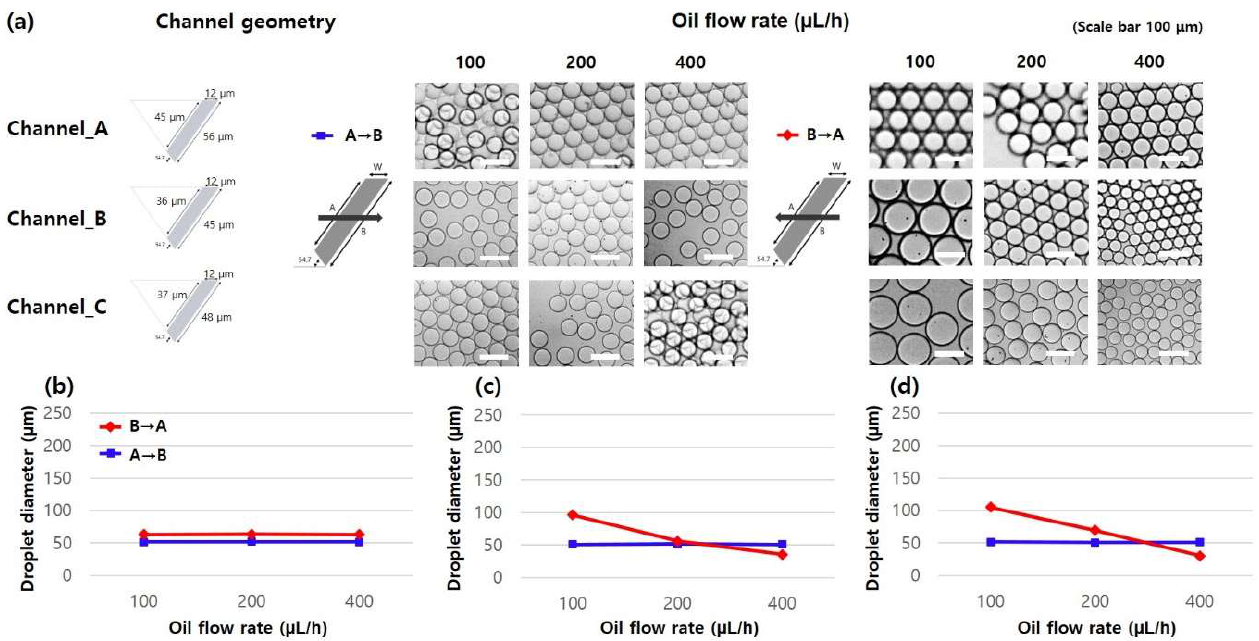
Figure 6. ( a ) Microscopic images of micro-droplets generated under various oil flow rate and direction conditions. Average diameters of micro-droplets generated in ( b ) Channel_A, ( c ) Channel_B, and ( d ) Channel_C designs. The flow rate of the water solution was fixed at 50 µL/h.